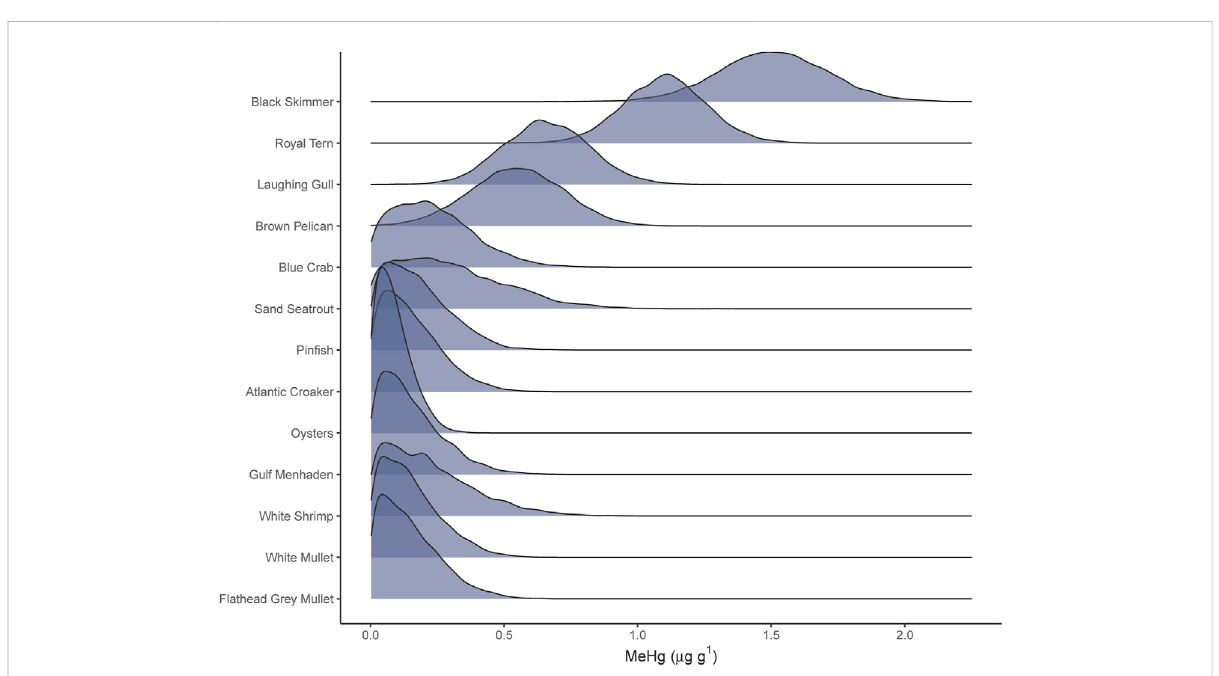
FIGURE 3 Posterior distributions estimated from Bayesian ANOVA to compare MeHg dry wt. concentrations across 13 species of bivalves, crustaceans, fi sh and seabirds in the aftermath of the 2010 Deepwater Horizon oil